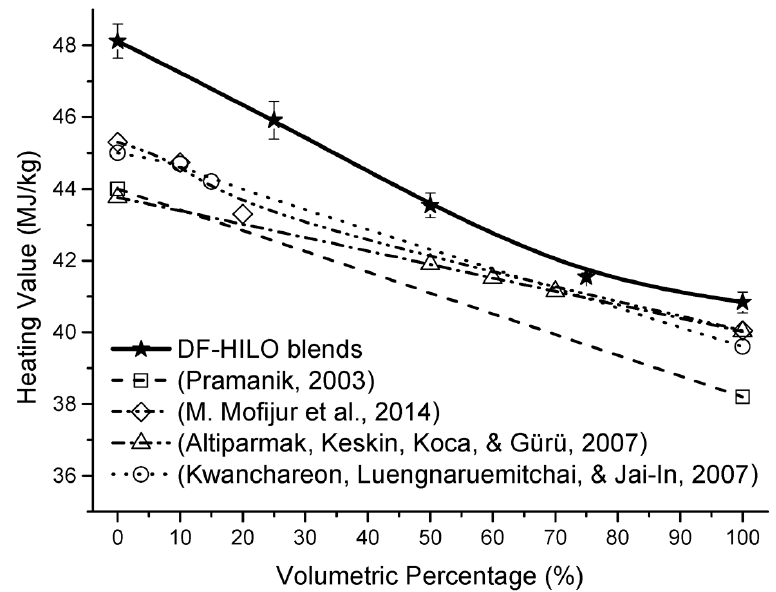
Figure 7. Variation of heating value with volumetric percentage [47–50].